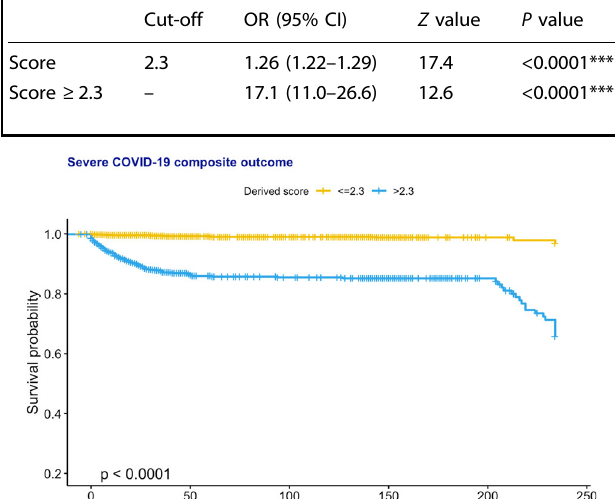
Table 8. Strati fi cation performance of score and dichotomized score system.